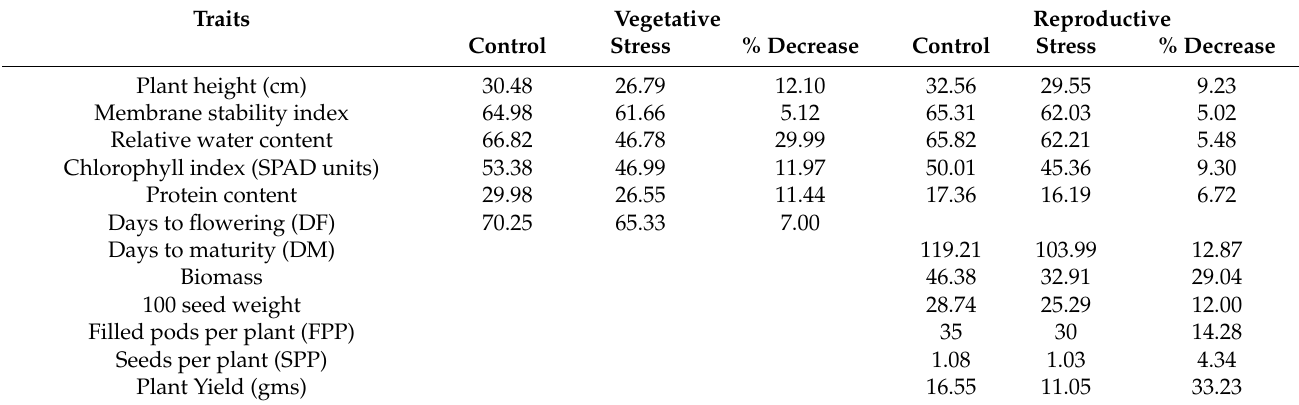
Table 4. Per cent reduction in different traits in chickpea